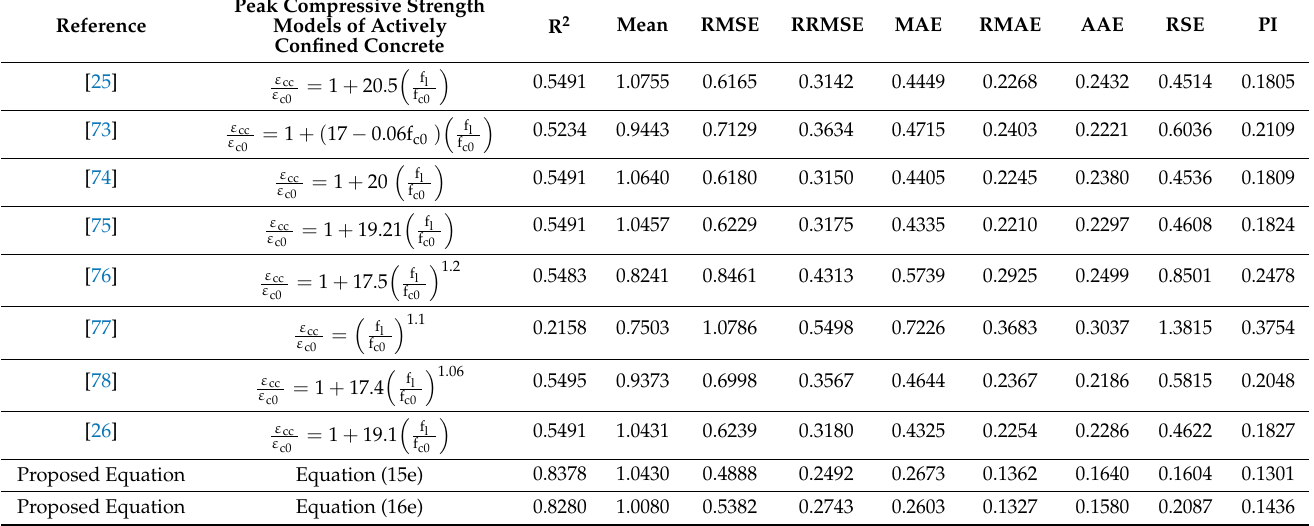
Table 14. Statistical indicators of the axial strain corresponding to the peak compressive strength models of actively confined